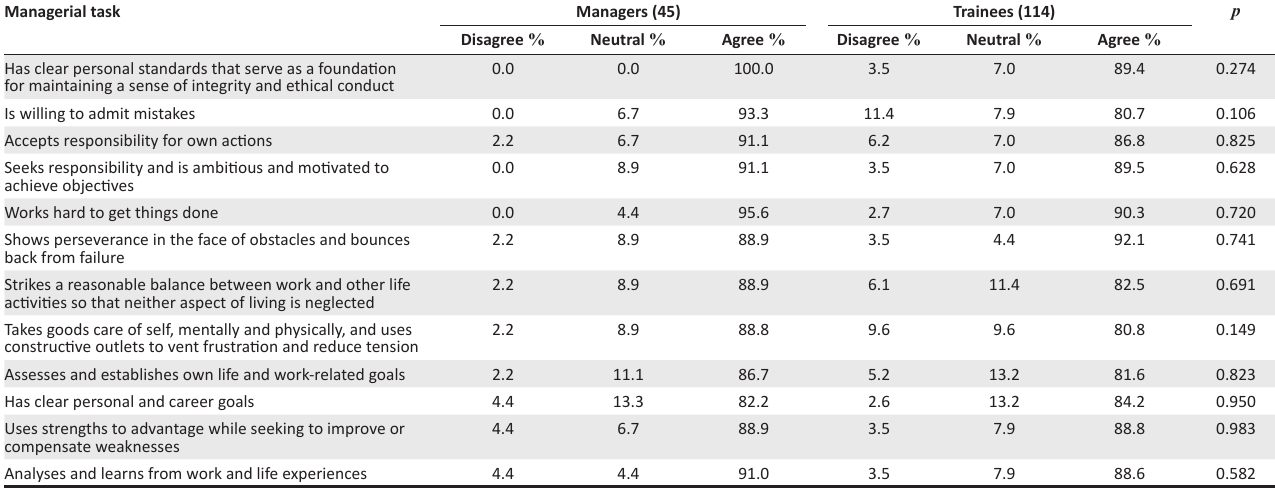
TABLE 9: Results for self-management.